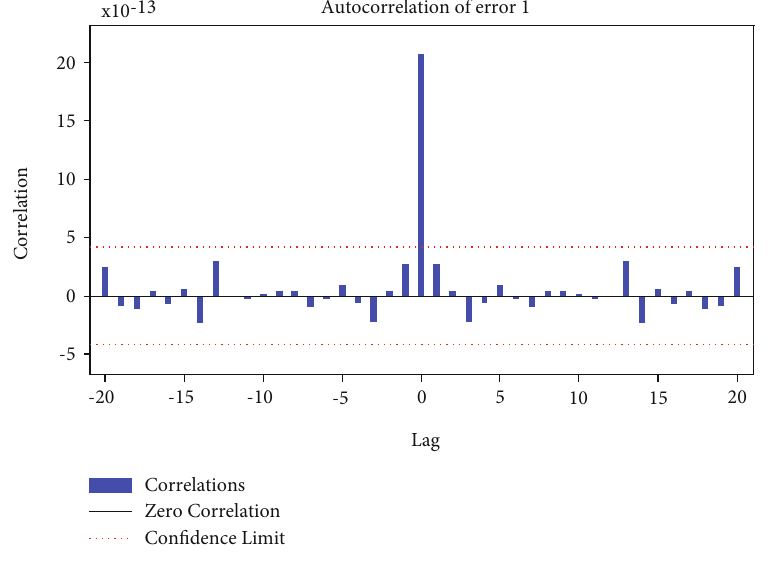
Figure 5: Autocorrelation for the error.